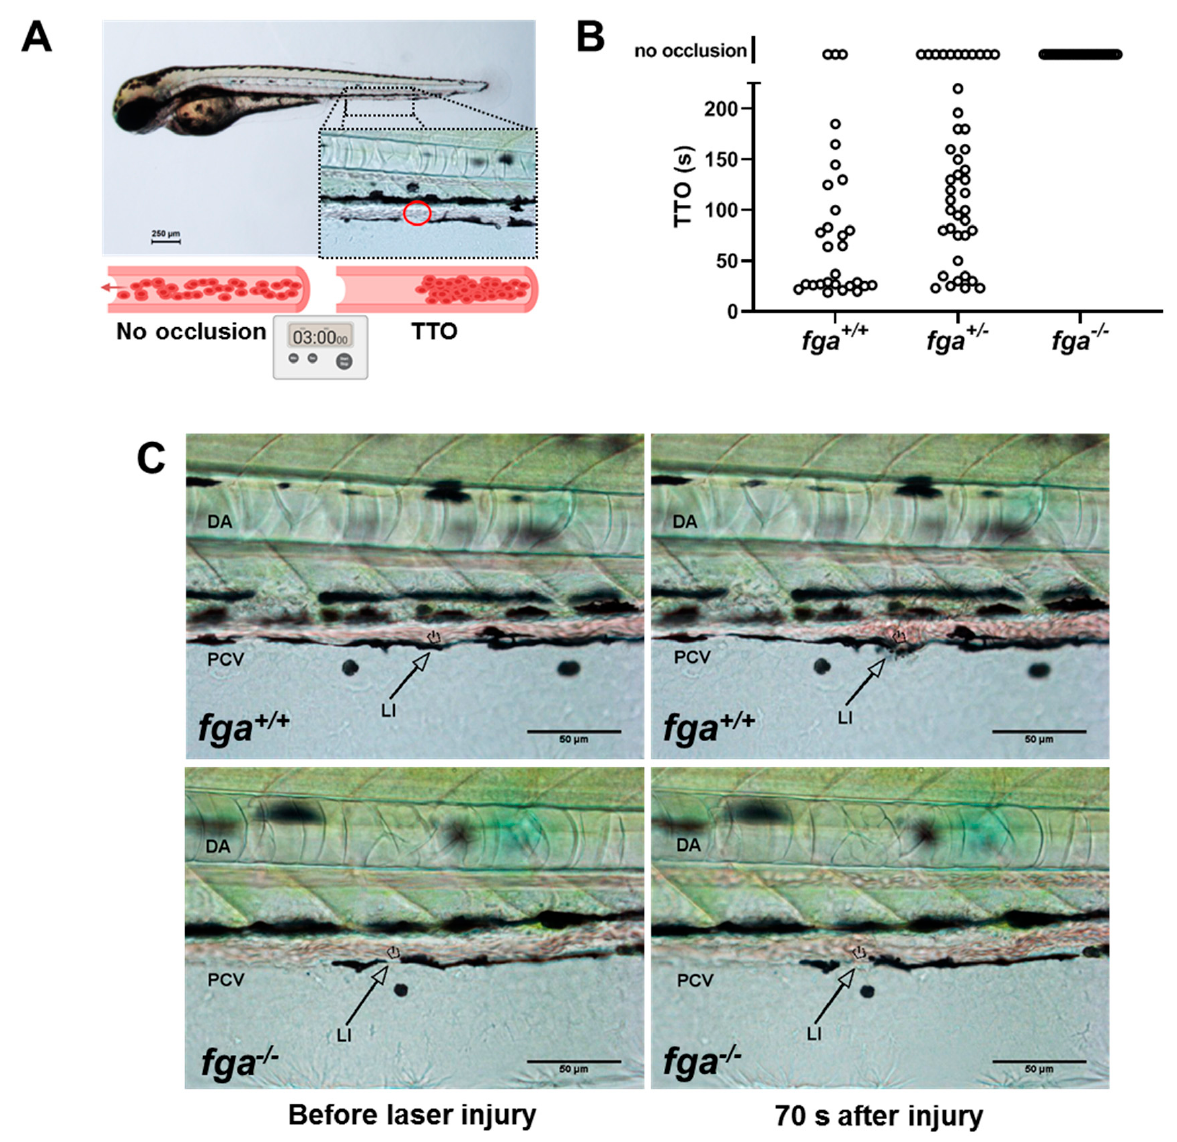
Figure 1. Laser-induced venous thrombosis in an afibrinogenemia model. ( A ) Diagram of time-to-occlusion (TTO) assay. The posterior caudal vein (PCV) is targeted for laser injury (region represented by the red circle) near the 5th somite distal to the cloaca and the time to PCV occlusion measured. A 3-min cut-off is used to determine no occlusion. ( B ) TTO in seconds (s) in 3 dpf fga +/+ , fga +/ − and fga − / − larvae. Each circle represents an individual larva. ( C ) Time lapse images of 3 dpf fga +/+ and fga − / − larvae before and after laser injury at the position marked (LI). DA is the dorsal aorta.